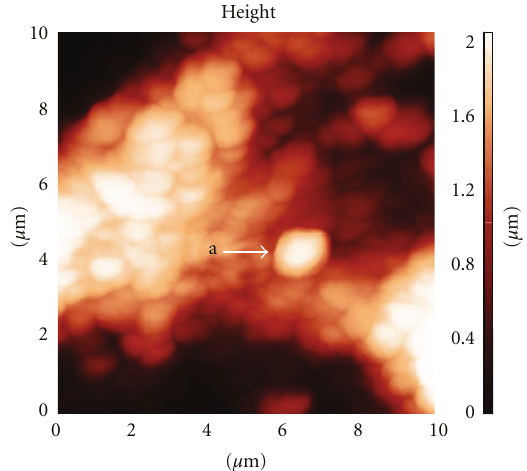
Figure 4: The disintegration of granular structure of the bone matrix of rat femur with osteoporosis. The arrow indicates the presence of free particle with signs of amorphization.AFM scan size of 10